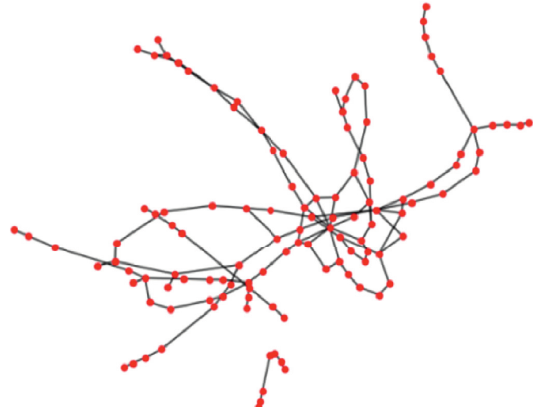
Figure 3: Road network topology map (desensitized